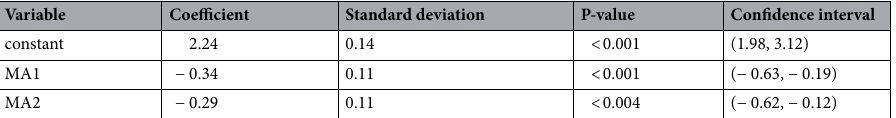
Table 3. The coefficients of the ARIMA(0,1,2) model for the number of road accidents in Kerman province (2015–2021).